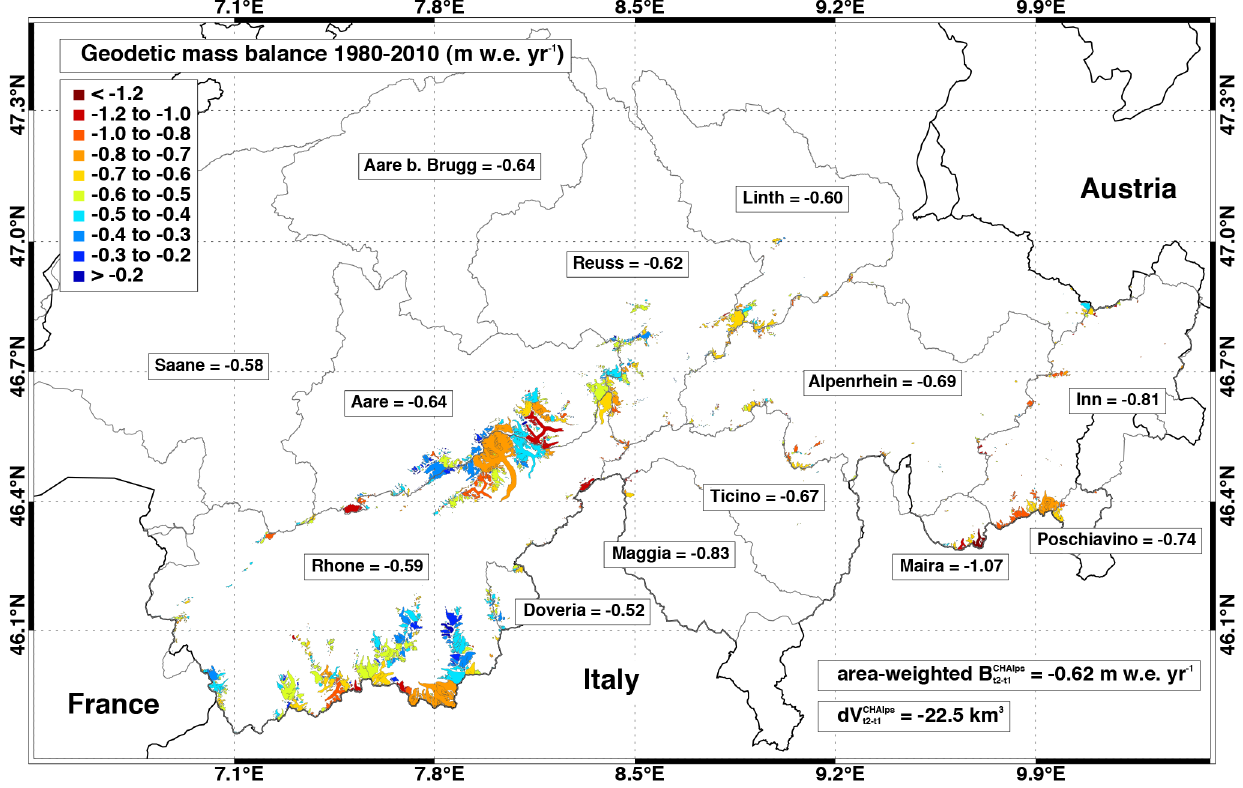
Figure 8. Mean area-weighted geodetic mass balance 1980–2010 for the main hydrological catchments and the entire Swiss